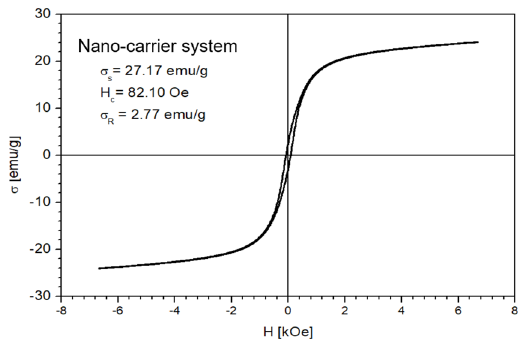
Figure 13. The hysteresis loop of nano-carrier system.